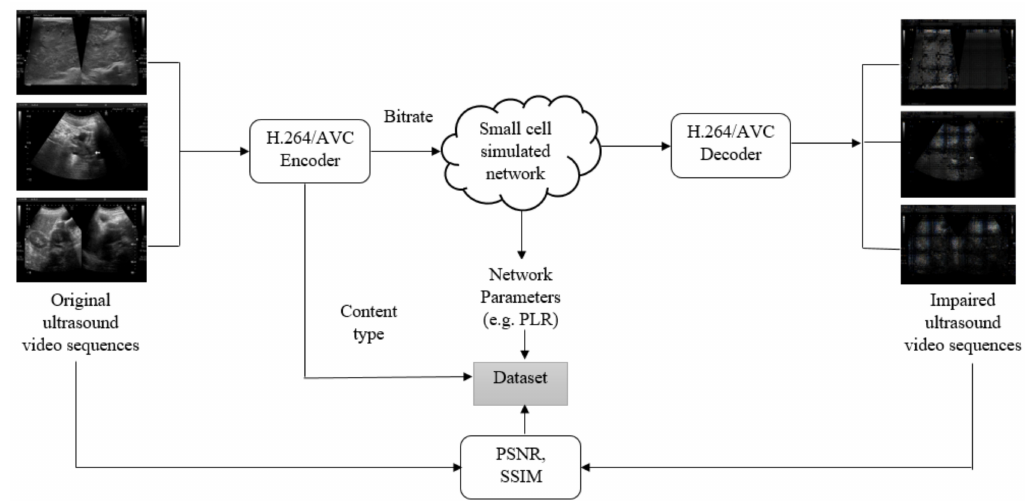
Figure 4. Experimental setup for dataset